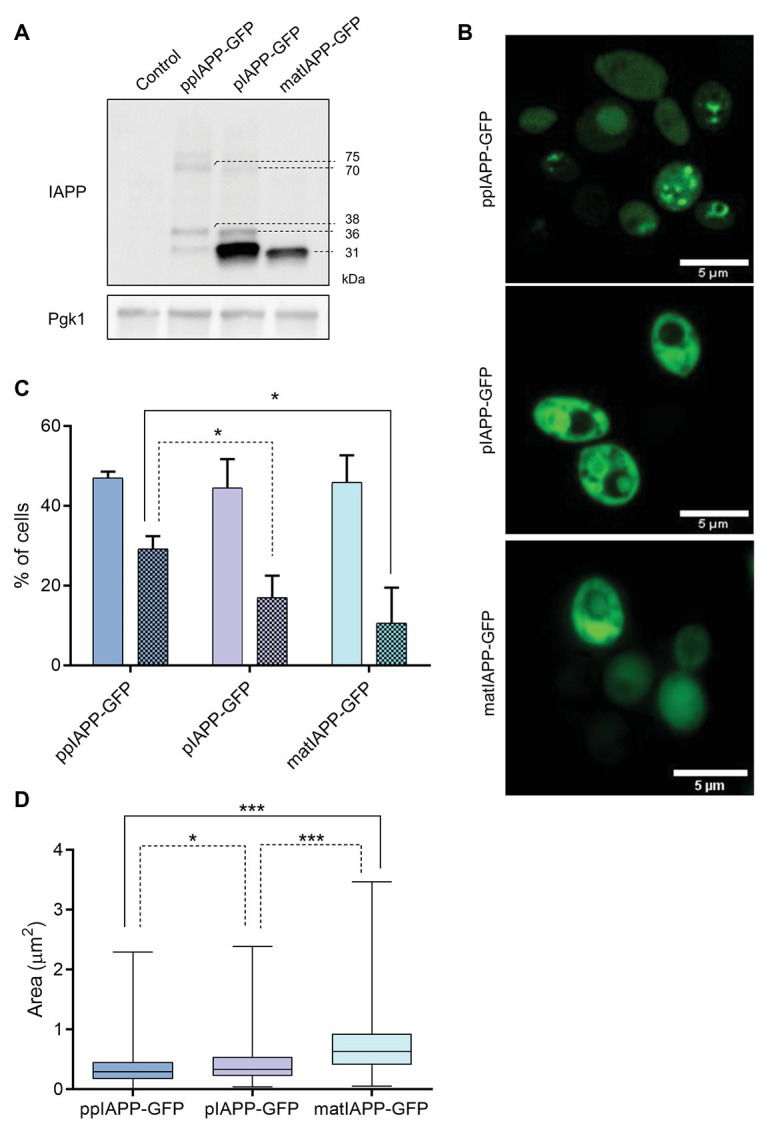
IAPP-GFP fusions expressed in yeast are processed and lead to the formation of intracellular aggregates with different morphologies. (A) BY4741 cells expressing IAPP-GFP fusions and the control construct were induced with galactose for 12 h, and proteins were assessed by immunoblotting using anti-IAPP antibody. Pgk1 was used as loading control. (B) Confocal fluorescence imaging of ppIAPP-GFP, pro-IAPP (pIAPP)-GFP, and mature IAPP (matIAPP)-GFP cells induced with galactose for 12 h. Scale bars correspond to 5 μm. (C) Cells under the same conditions were analyzed by fluorescence microscopy, and the number of fluorescent cells as well as the number of cells containing aggregates was monitored. Full colors: GFP + cells; colored patterns: cells with aggregates. (D) Aggregate area was measured in cells containing aggregates. Representative images are shown, and the values represent mean ± SD from at least three independent experiments. Statistical differences are denoted as *p < 0.05 and ***p < 0.001.